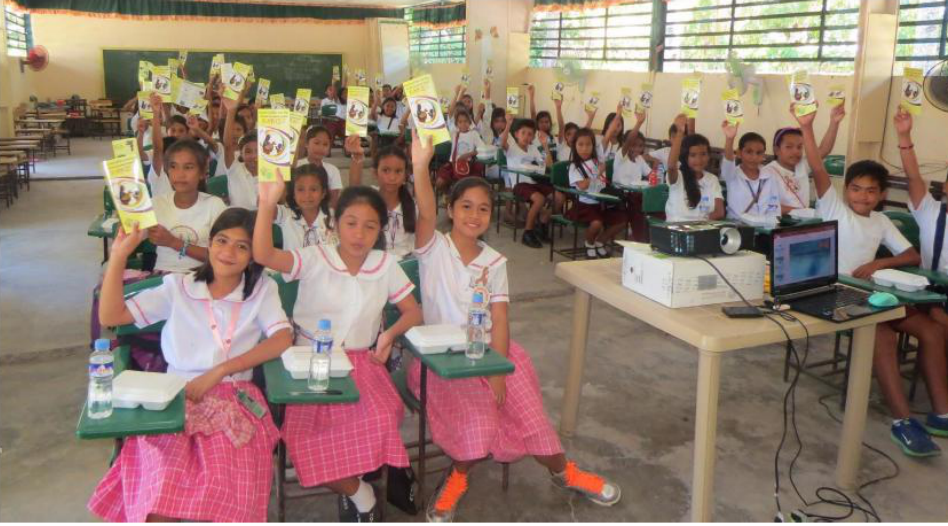
Figure 2. Rabies information dissemination campaign for elementary pupils during Rabies Awareness Month (March) in the province of Masbate.